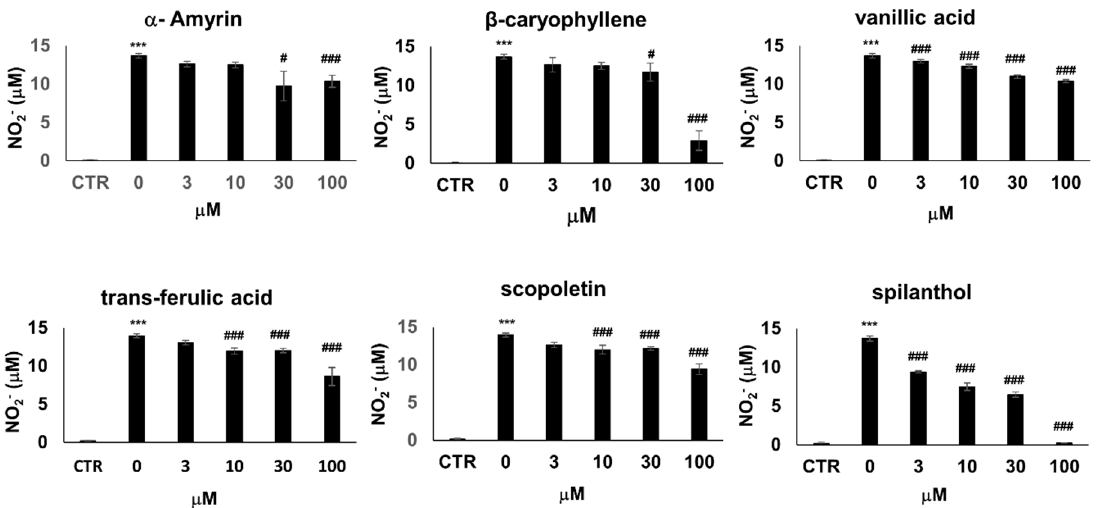
Figure 3. From a panel of selected chemical substances present in S. acmella extracts spilanthol is the most active in suppressing NO production. NO production of RAW264.7 cells activated with 10 ng / mL LPS + 10 ng / mL IFN γ for 24 h. Cells were pretreated with increasing concentrations (0–100 µ M) of α -amyrin, β -caryophyllene, vanillic acid, trans-ferulic acid, scopoletin, and spilanthol. NO production was assessed from NO 2 − levels present in the cell culture medium. (* Stars indicate significant (*** p < 0.001) induction of NO production by IFN γ + LPS. #Hashmarks indicate significant (# p <